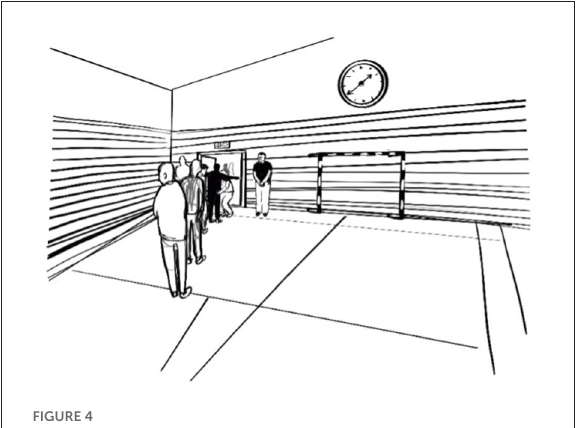
FIGURE4 Leaving the gym. Illustrated by Jenny